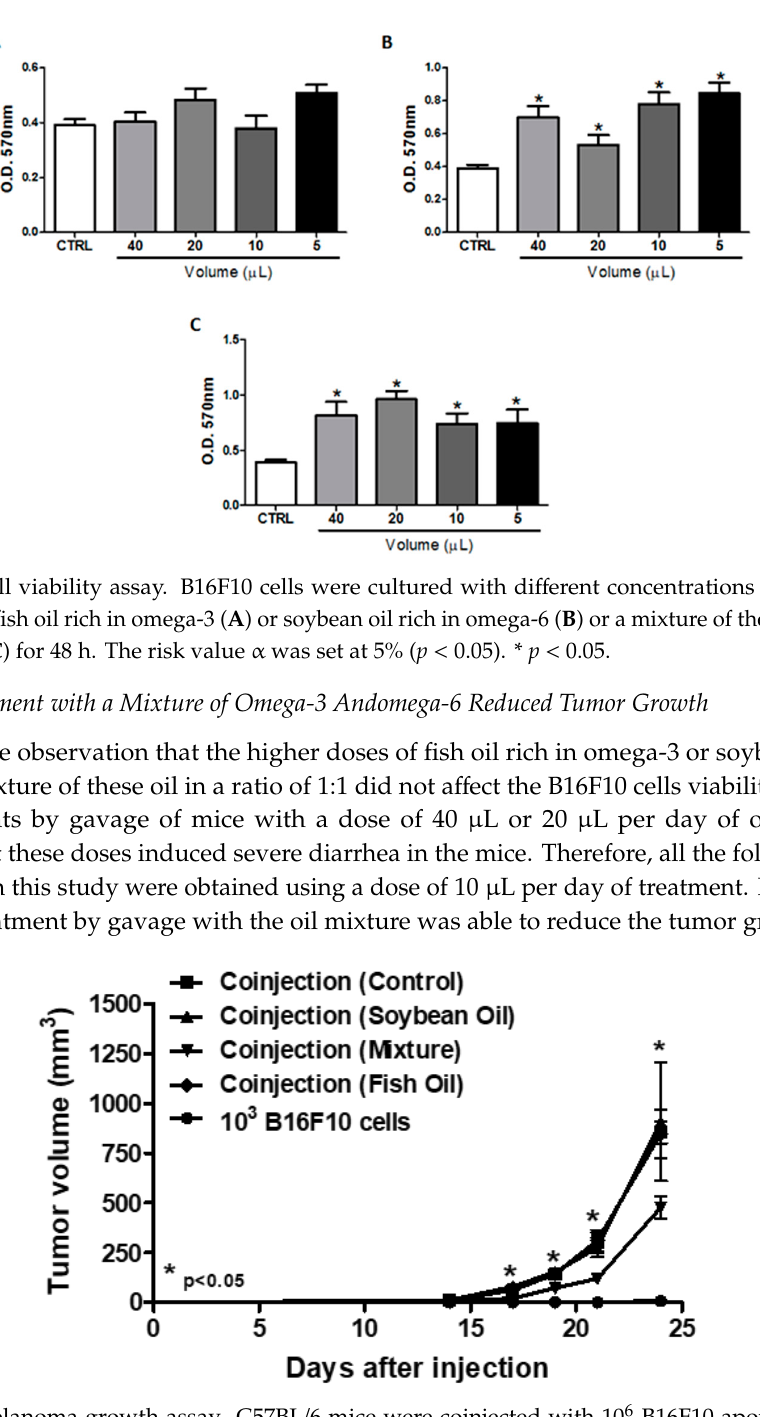
Figure 2. Melanoma growth assay. C57BL / 6 mice were coinjected with 10 6 B16F10 apoptotic cells plus a sub-tumorigenic dose of 10 3 B16F10 viable melanoma cells in a subcutaneous tissue. After the coinjection, the mice were treated by gavage during five consecutive days with fish oil rich in omega-3 or soybean oil rich in omega-6 or a mixture of these oils in a ratio of 1:1. All experiments were carried out using groups of five 6–8 week old female mice in, at least, two independent experiments, and it was considered as harboring tumors when the subcutaneous mass reached 4 mm 3 (palpable tumor). The risk value α was set at 5% ( p < 0.05). * p < 0.05.